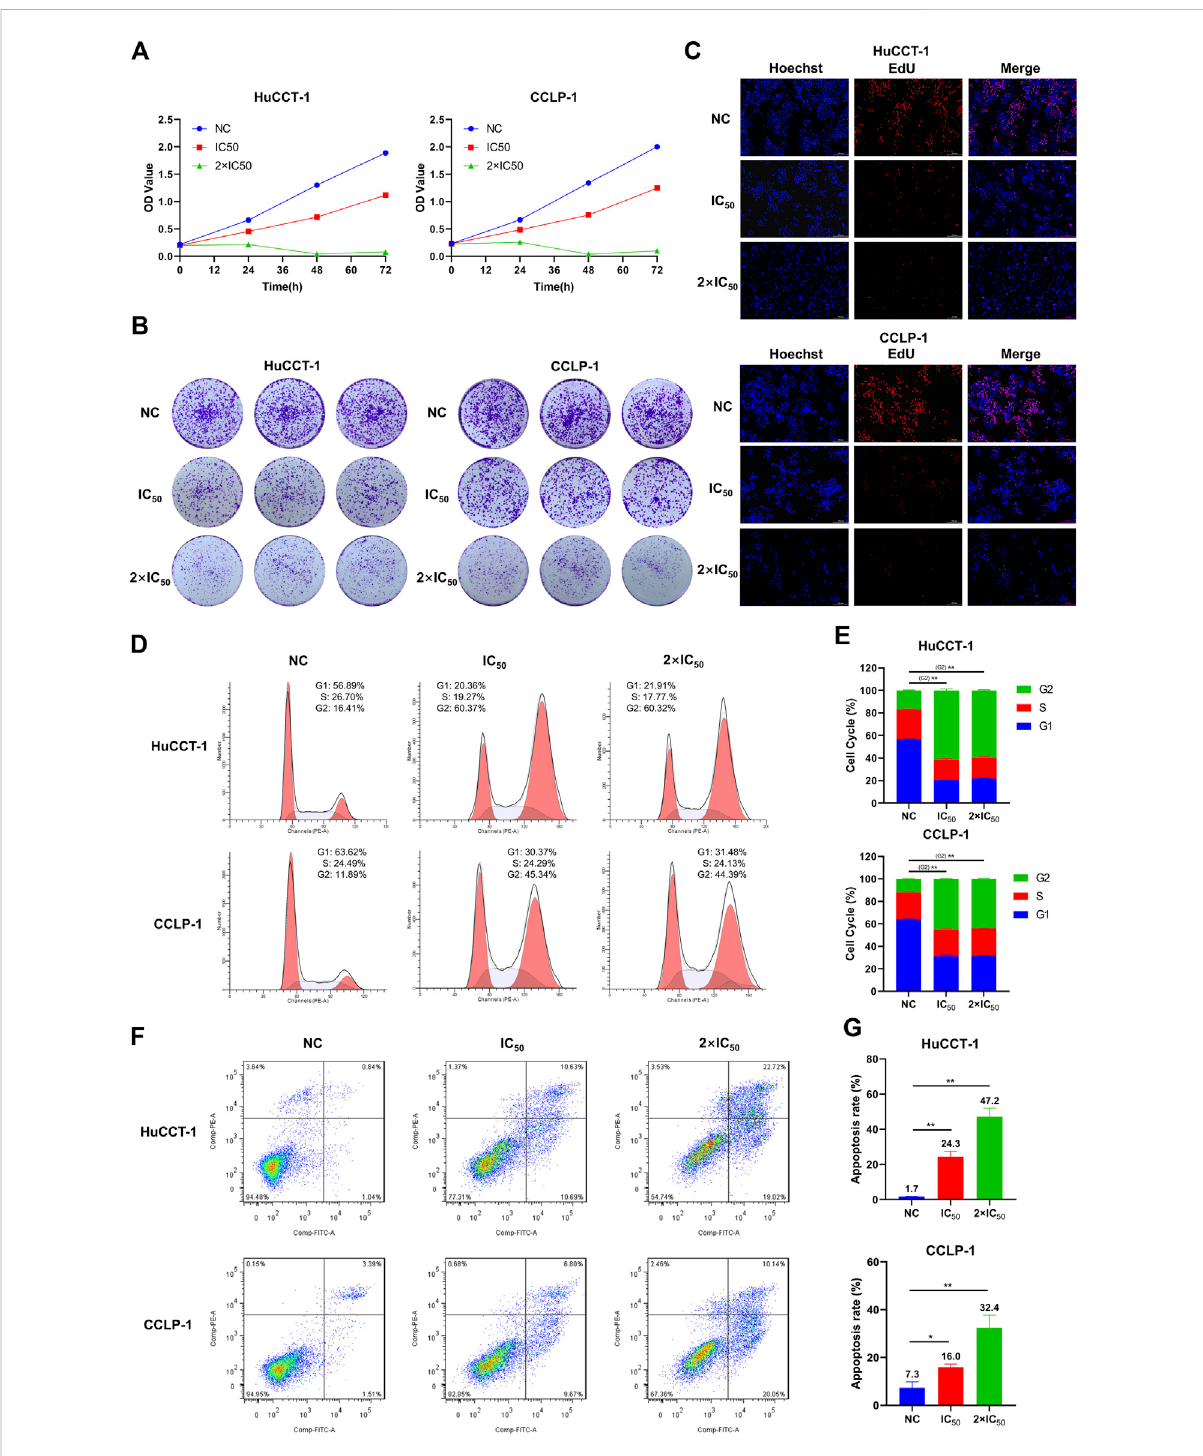
FIGURE 4 MLN2238 inhibited the proliferation, blocked the cell cycle in the G2/M phase and induced apoptosis in iCCA cells. The proliferation ability of HuCCT-1 and CCLP-1 cells after MLN2238 treatment were evaluated via (A) cell counting kit-8 analysis, (B) clone formation and (C) EdU viability assay. (D) Cell cycle distribution was detected by fl ow cytometry analysis after IC50 and 2×IC50 concentration of MLN2238 treatment for 24 h. (E) The histogram shows the percentage of HuCCT-1 and CCLP-1 cells in G1-S-G2-phase. (F) The apoptotic iCCA cells were measured via fl ow cytometry analysis after treatment with IC50 and 2×IC50 concentration of MLN2238 for 24 h. (G) The histogram displays the quantitative analysis of the apoptosis rate of HuCCT-1 and